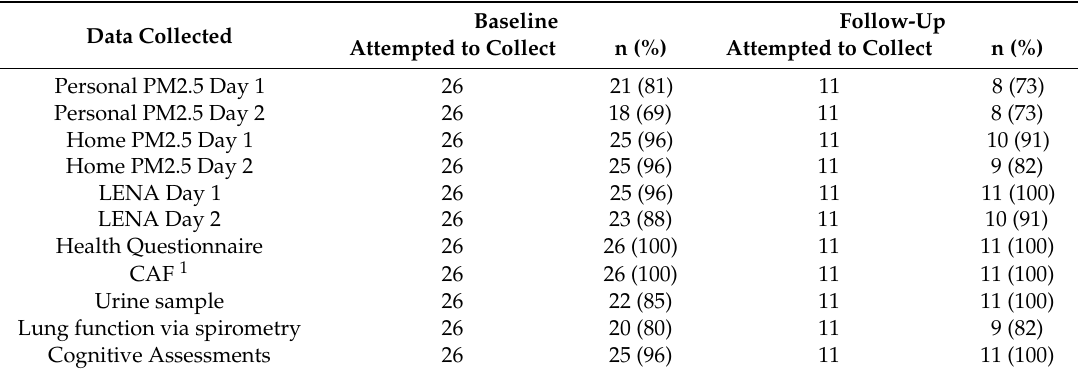
Table 2. Data completion table for all participants, by baseline and follow-up visits.